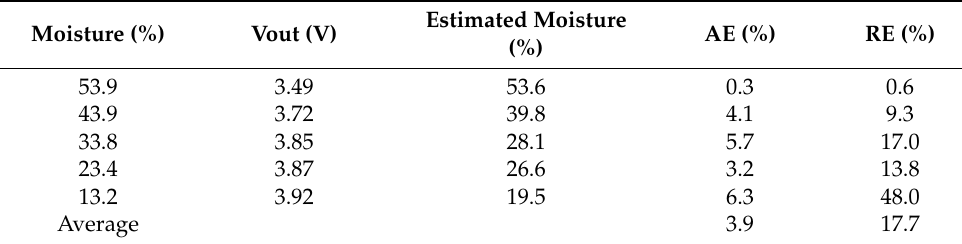
Table 11. Verification NP1, 750